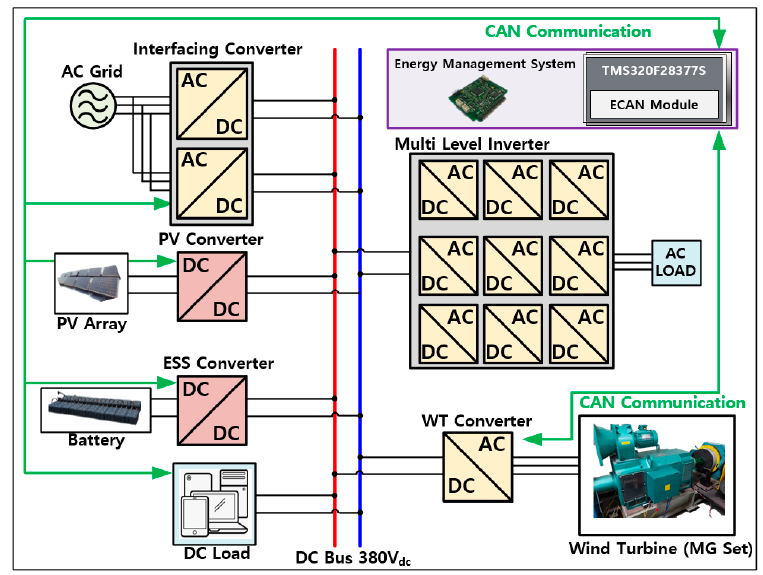
Figure 2. Configuration of DC microgrid with EMS.